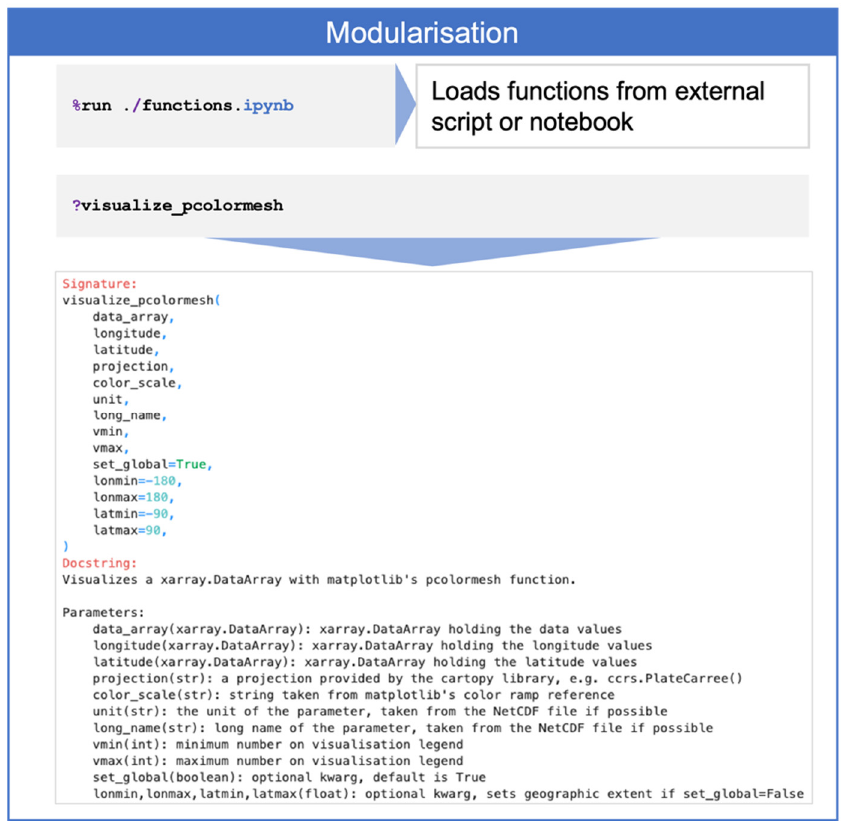
Figure 6. Magic command (%run) to load content, e.g., functions, from an external script or notebook. Once the command has been executed, the functions can be used in a notebook. The docstring of a function can be called by adding a question mark in front of the function name.